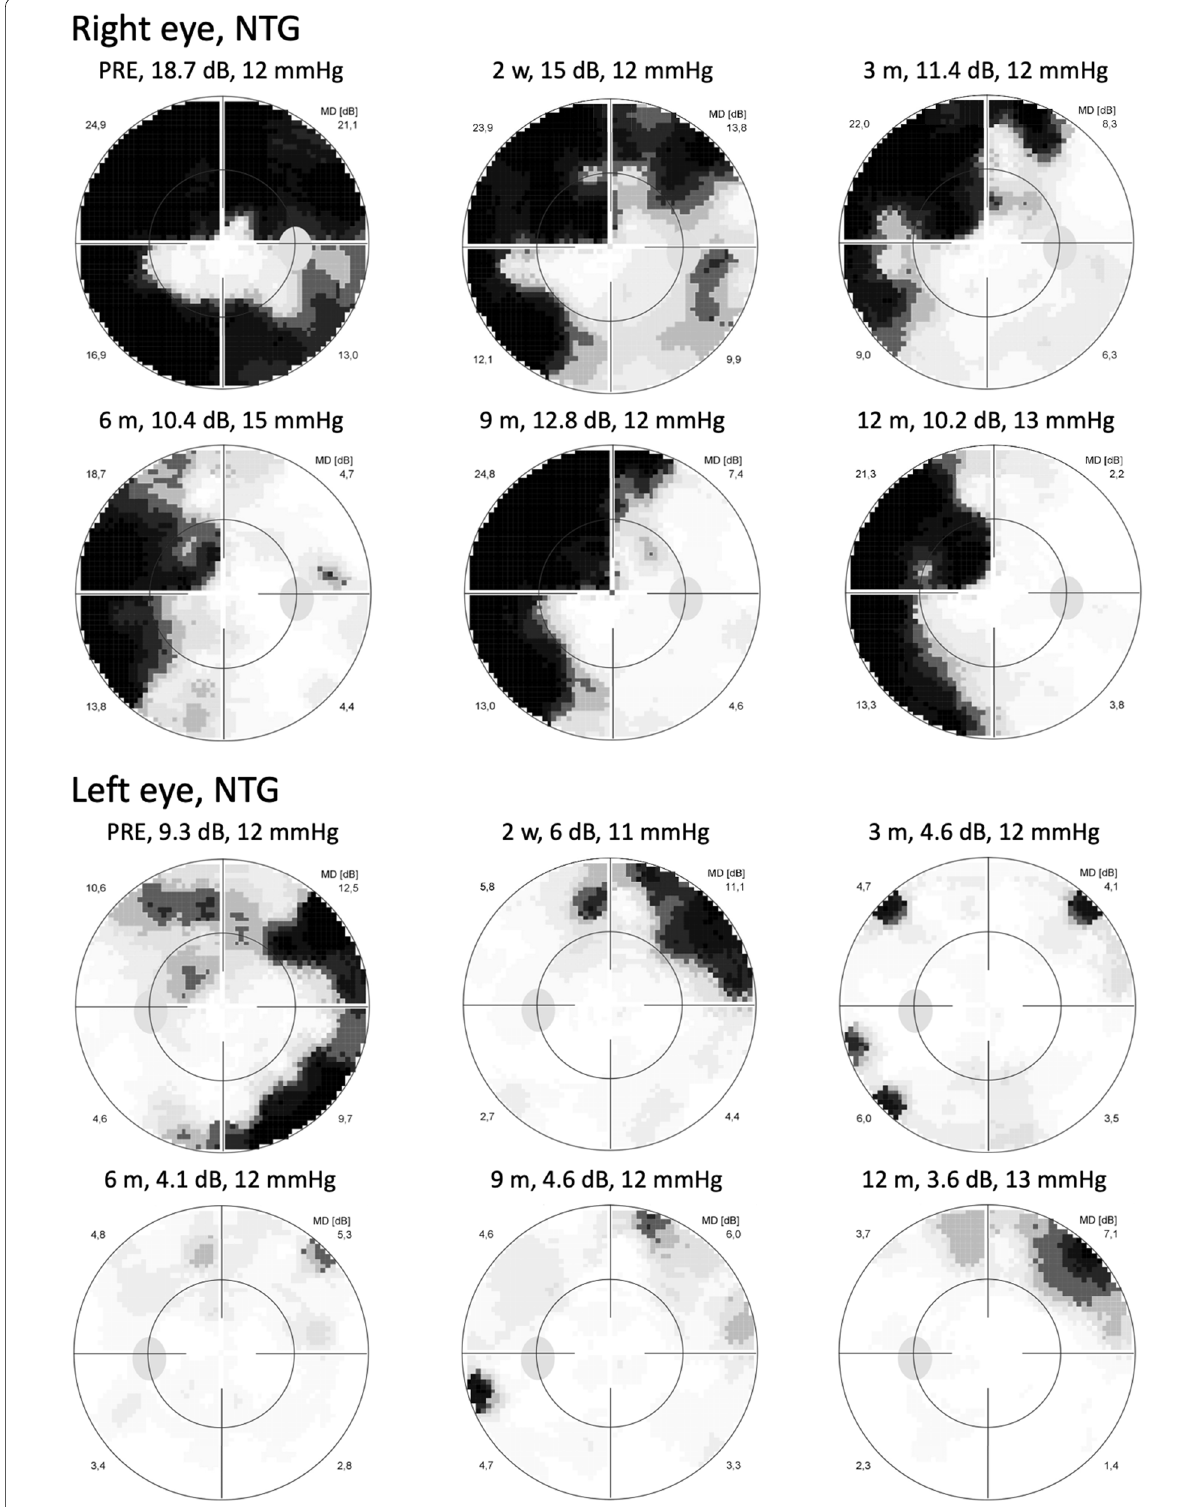
Fig. 3 Visual fields of the right (top) and the left eye (bottom) with normal tension glaucoma (NTG) of a female patient, 70 years old. With each perimetry at time points PRE, 2 weeks, 3, 6, 9, and 12 months after ONS treatment mean defect (MD) and intraocular pressure are